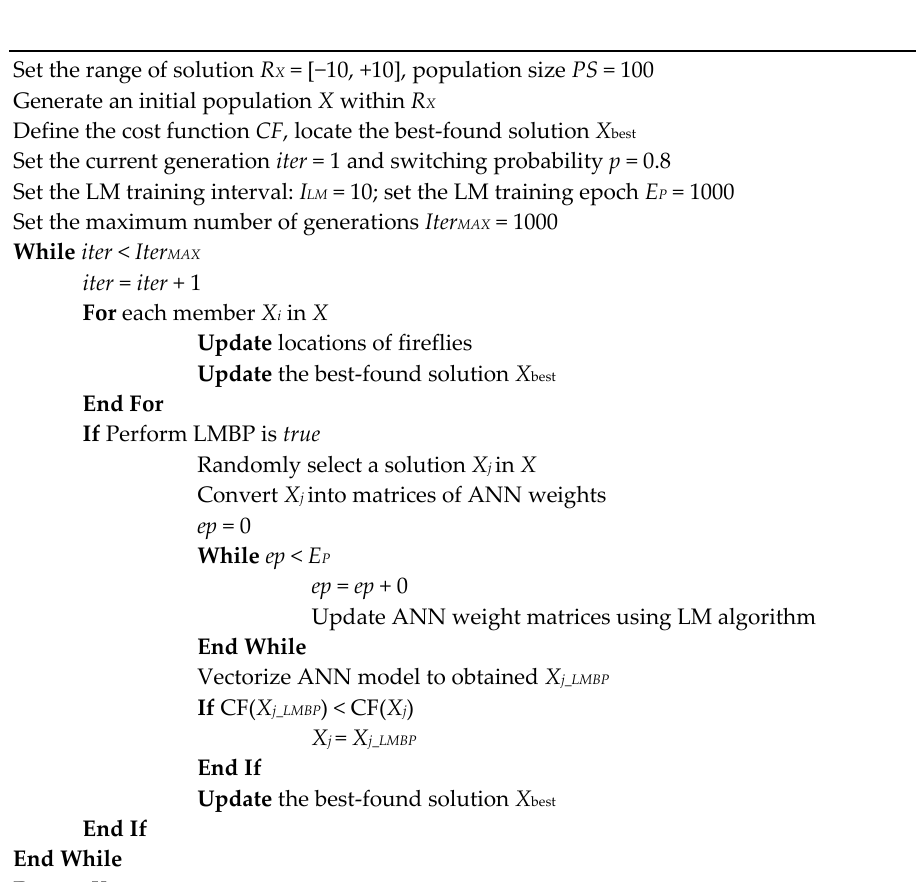
Figure 9. The prosed hybrid FA-LM algorithm for training the ANN model.